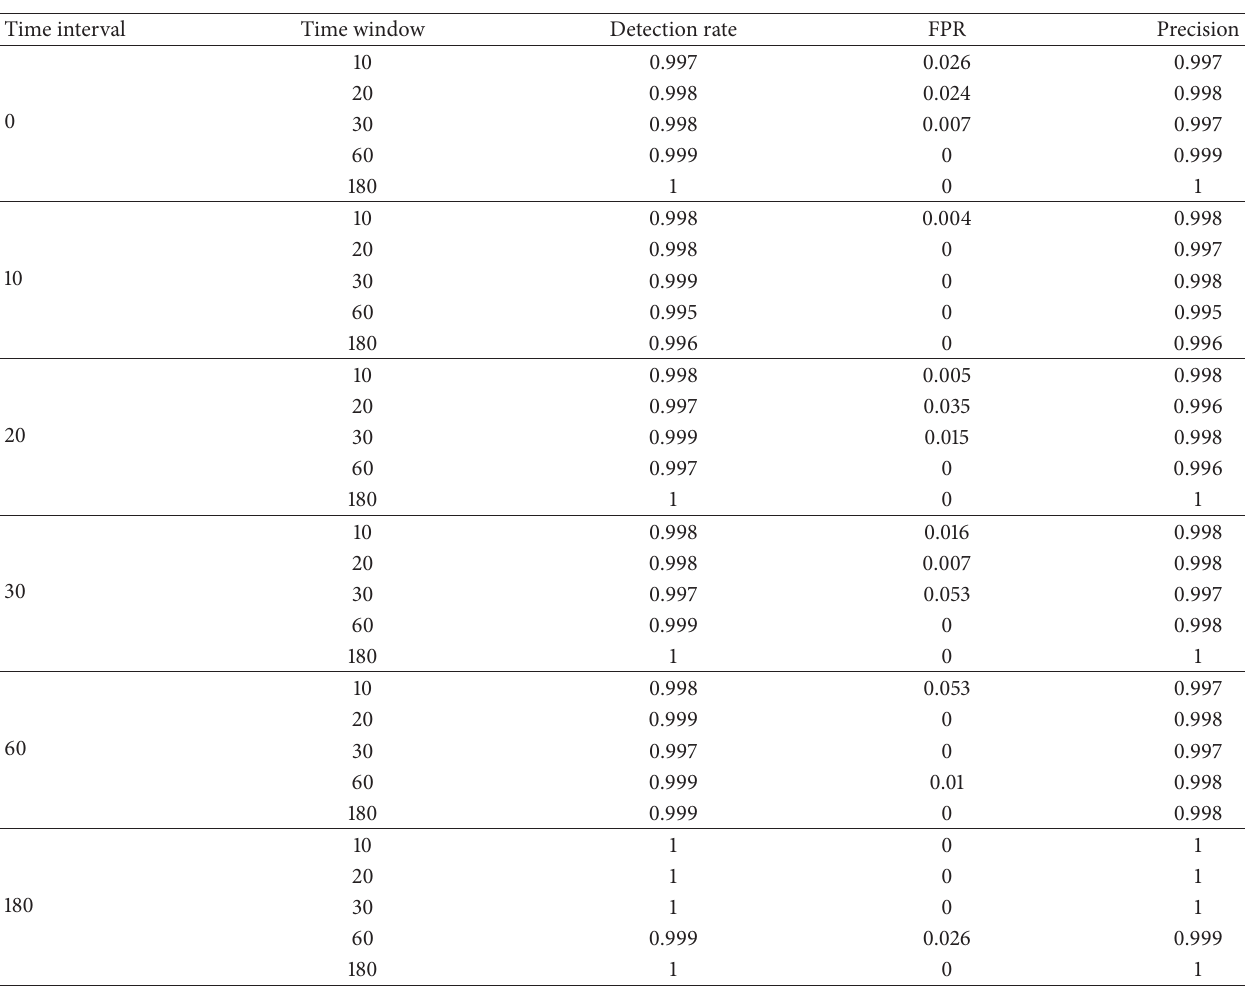
Table 3: Detection rate and precision of node-based